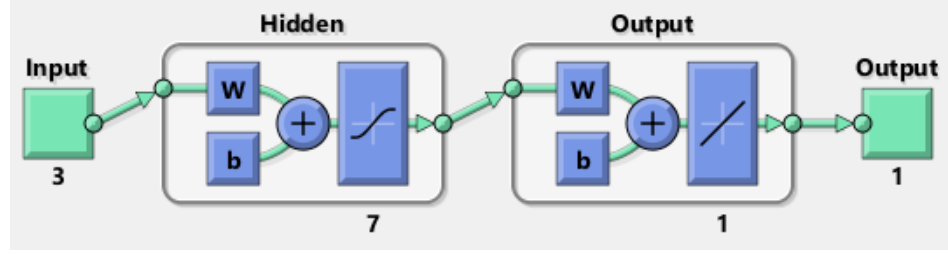
Figure 3. ANN’s architecture used in this study.